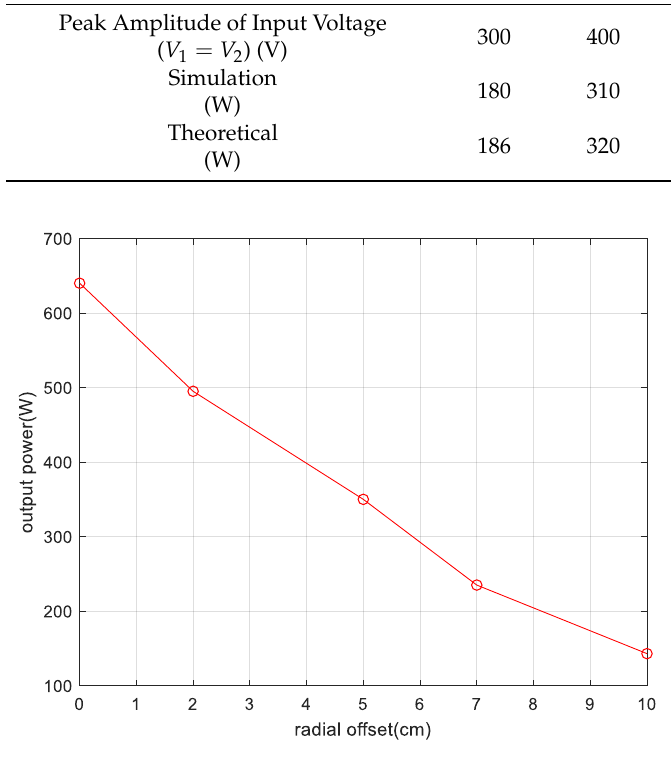
Figure 7. The output power and the radial misalignment.